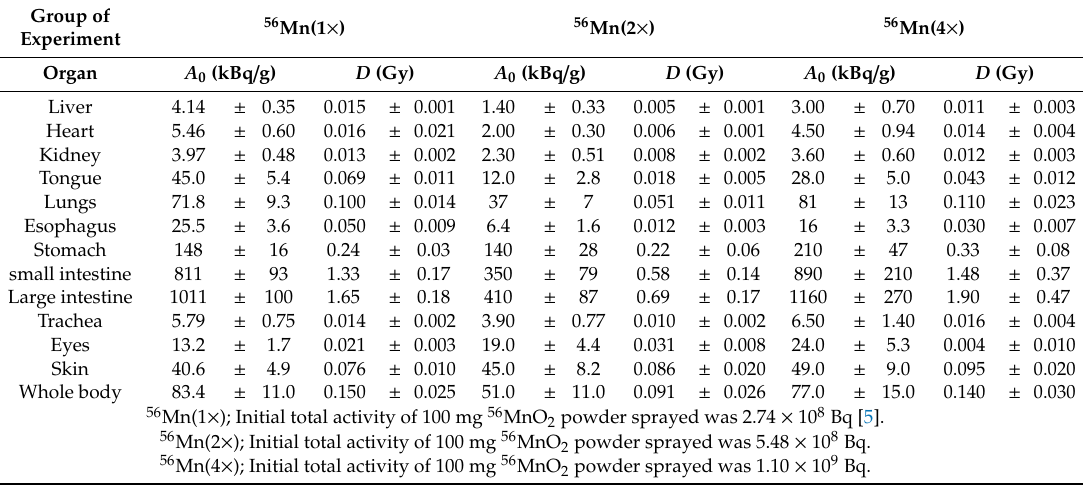
Table 1. 56 Mn specific activities A o and tissue average accumulated absorbed doses D of internal irradiation in di ff erent organs and tissues of experimental